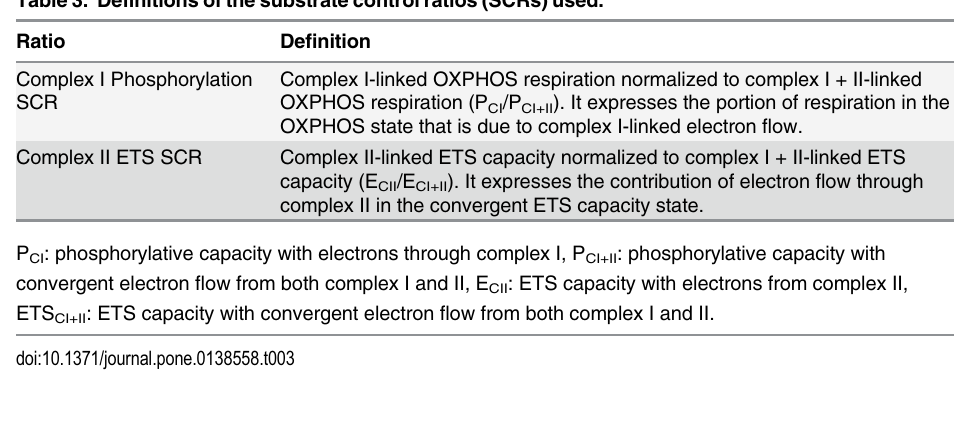
respiration that is due to proton